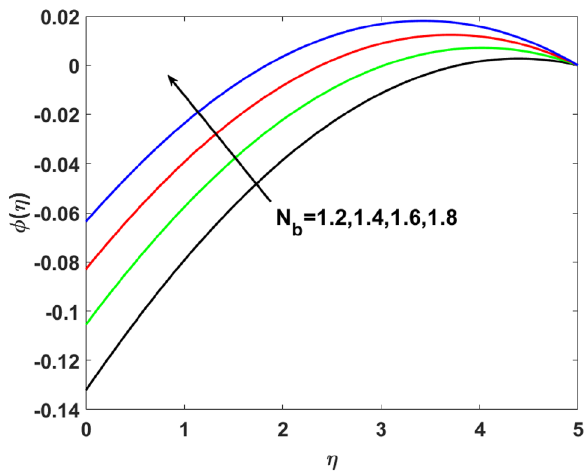
Figure 18. φ(η) versus N b .